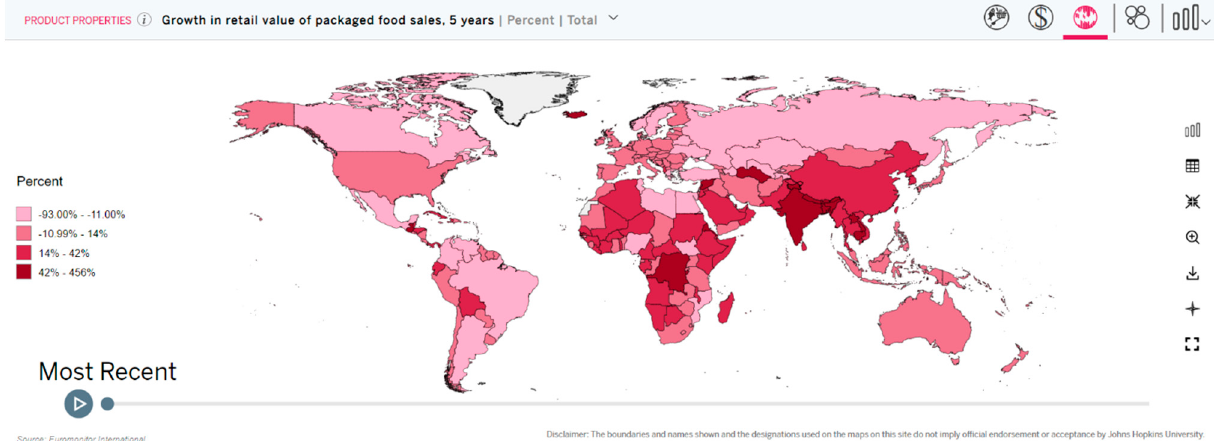
Figure 4. FSD visualization example—5-year growth in retail value of packaged foods. Source: (Euromonitor International